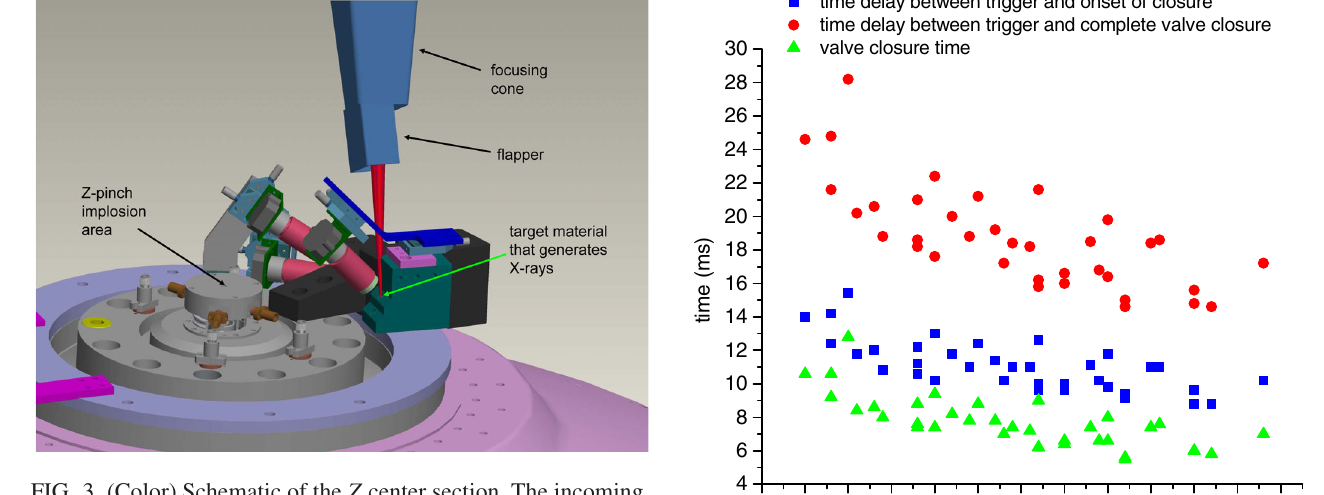
3. (Color) Schematic of the Z center section. The incoming laser beam is enclosed all the way up to the target. When the Z -pinch debris hits the flapper it should self-close and prevent debris from entering the focusing